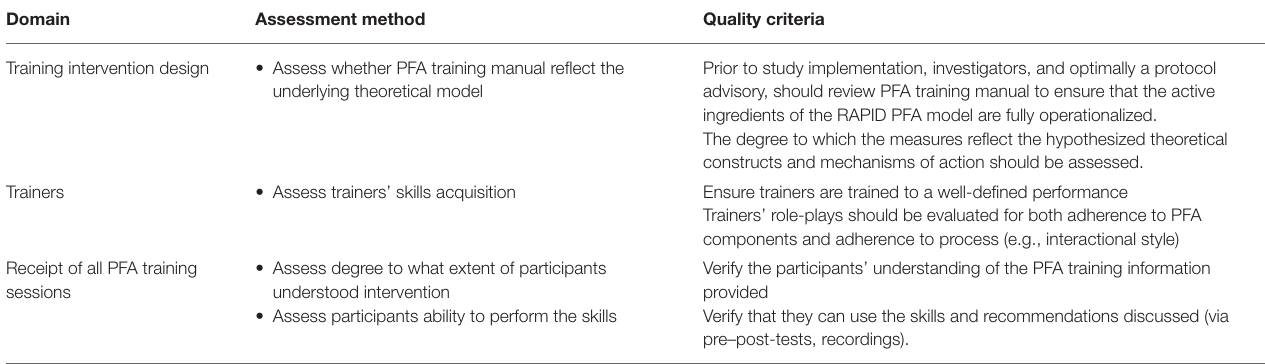
TABLE 5 | Fidelity checklist of PFA training